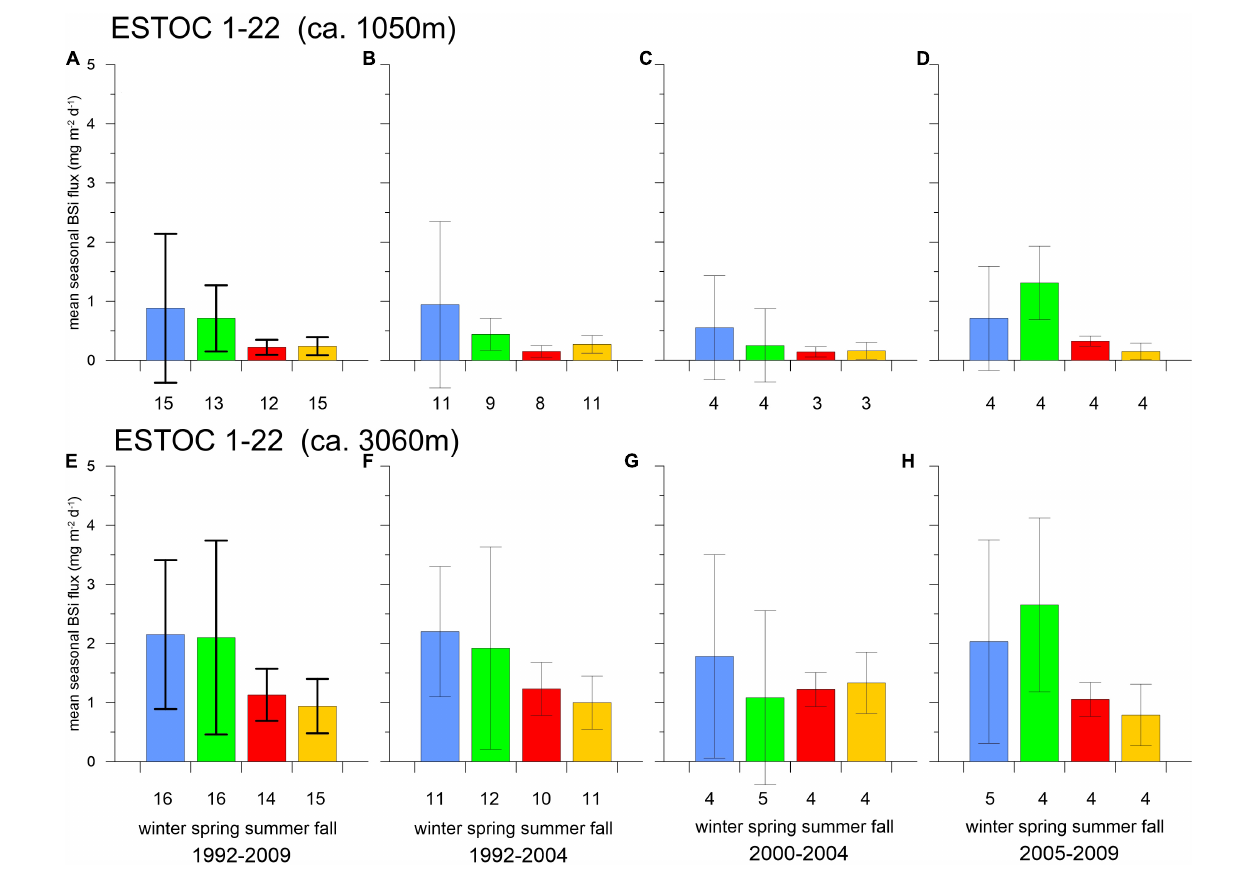
FIGURE 8 | Seasonal means of BSi (mg m − 2 d − 1 ) and standard deviations (SD) for the total sampling period, for 1992–2004, 2000–2004, and 2005–2009 derived from the 1 km (A–D) and 3 km (E–H) ESTOC traps. The BSi flux patterns change from winter to spring since 2005. Number of observations are given in numbers below the x-axis; note the low numbers of observations (4–5) for fluxes since